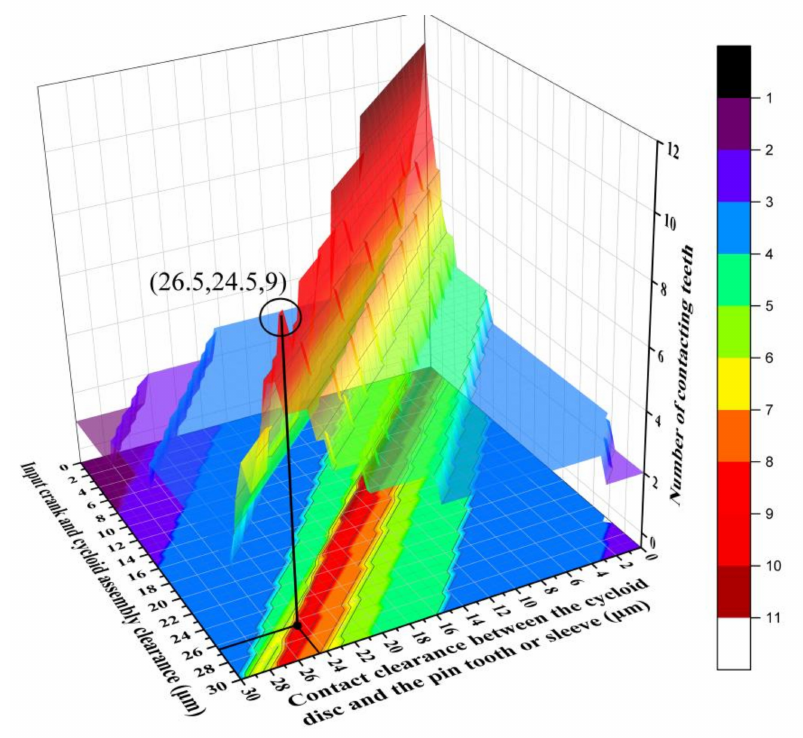
Figure 8. Number of teeth meshed depending on system clearance.